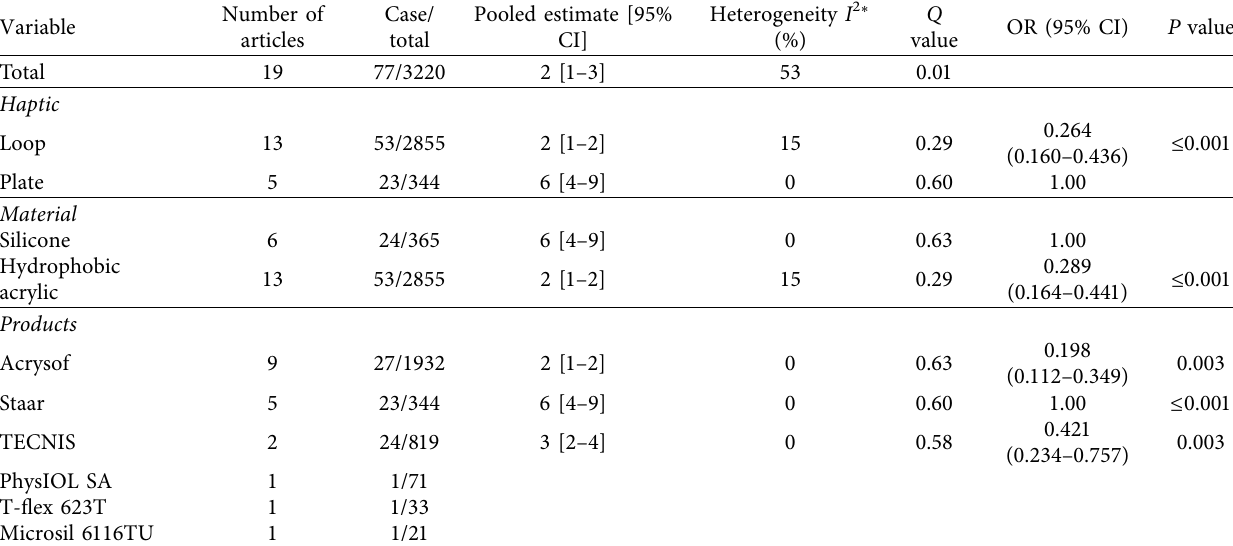
Figure 3: The forest plots displaying the pooled incidence rate of repositioning surgery of (a) loop-haptic toric IOLs and (b) plate-haptic IOLs. Table 2: The pooled incidence rate of repositioning surgery with different